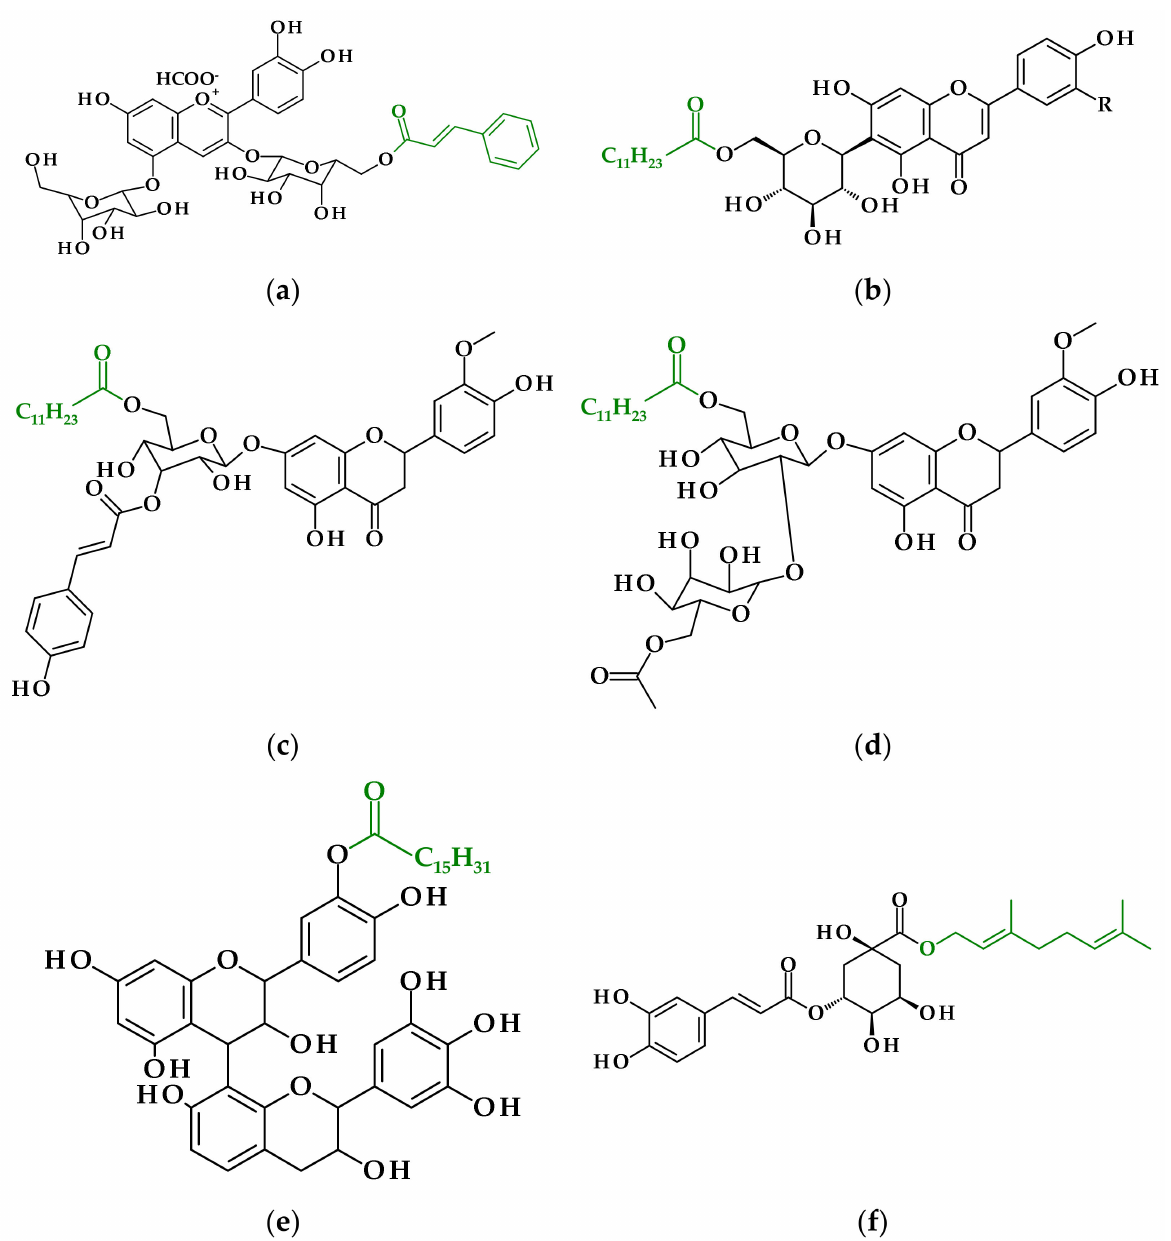
Figure 3. Phenolic derivatives from lipophilized plant extracts other than fruits extracts: ( a ) cyanidin- 3- O -(6 (cid:48)(cid:48) -cinnamoyl)glucoside-5- O -glucoside-derivative of anthocyanins (glycosides of anthocyani- dins) [14]; ( b ) isoorientin-6 (cid:48)(cid:48) -laurate/isovitexin-6 (cid:48)(cid:48) -laurate-derivative of flavonoid C-glycosides [28], isoorientin: R = OH, isovitexin: R = H; ( c ) laurate ester of chrysoeriol-7- O - β -D-(3 (cid:48)(cid:48) - E - p -coumaroyl)- glucopyranoside-derivative of monosaccharidic flavone [29]; ( d ) laurate ester of chrysoeriol-7-[6 (cid:48)(cid:48)(cid:48) - O -acetyl- β -D-allosyl-(1 → 2)- β -D-glucopyranoside]–derivative of disaccharidic flavone [29]; ( e ) pro- cyanidin and prorobinetinidin heteroduplex esterified with palmitic acid–derivative of proantho- cyanidin [17]; ( f ) geranyl chlorogenate–derivative of chlorogenic acid